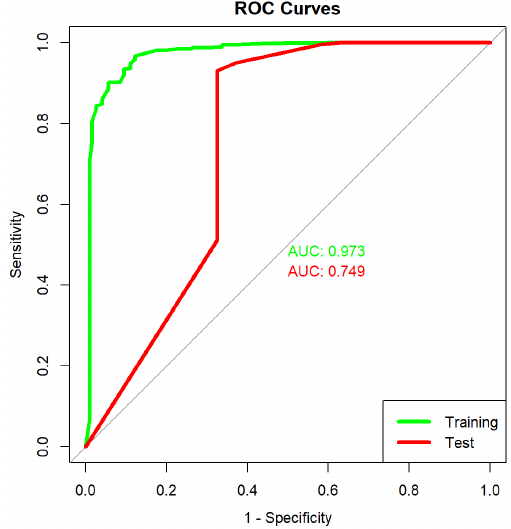
Figure 12. TESSOM ROC curve for training and testing.